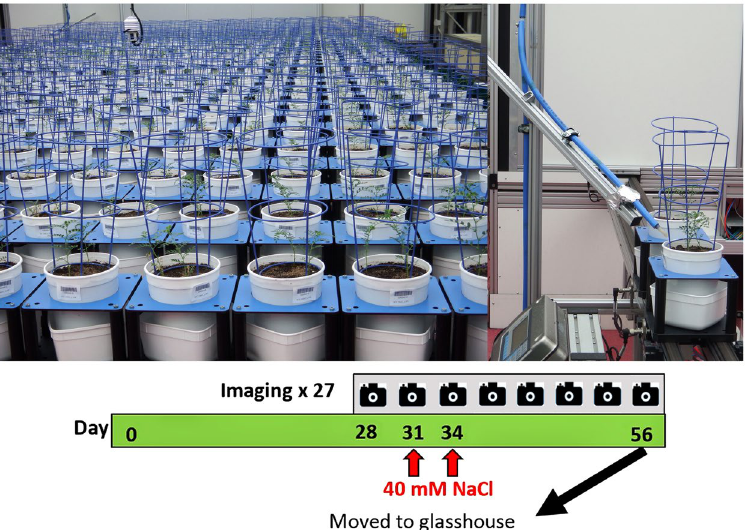
Figure 1. Salinity tolerance phenotyping in The Plant Accelerator. Plants were imaged at 28 DAS for 3 consecutive days prior to 40 mM NaCl application in two increments over 2 days. Plants were daily imaged until 56 DAS. Right pane shows 6-week-old chickpea plants on conveyor belts leaving the imaging hall proceeding to an automatic weighing and watering station.